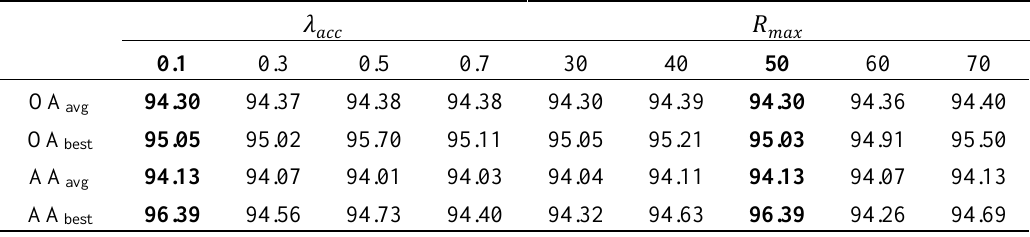
Table 10. Classification accuracies by region-based GeneSIS for varying values of 𝑅 and 𝜆 in the Indiana dataset. The results corresponding to the selected parameter values 𝑎𝑐𝑐 are shown in